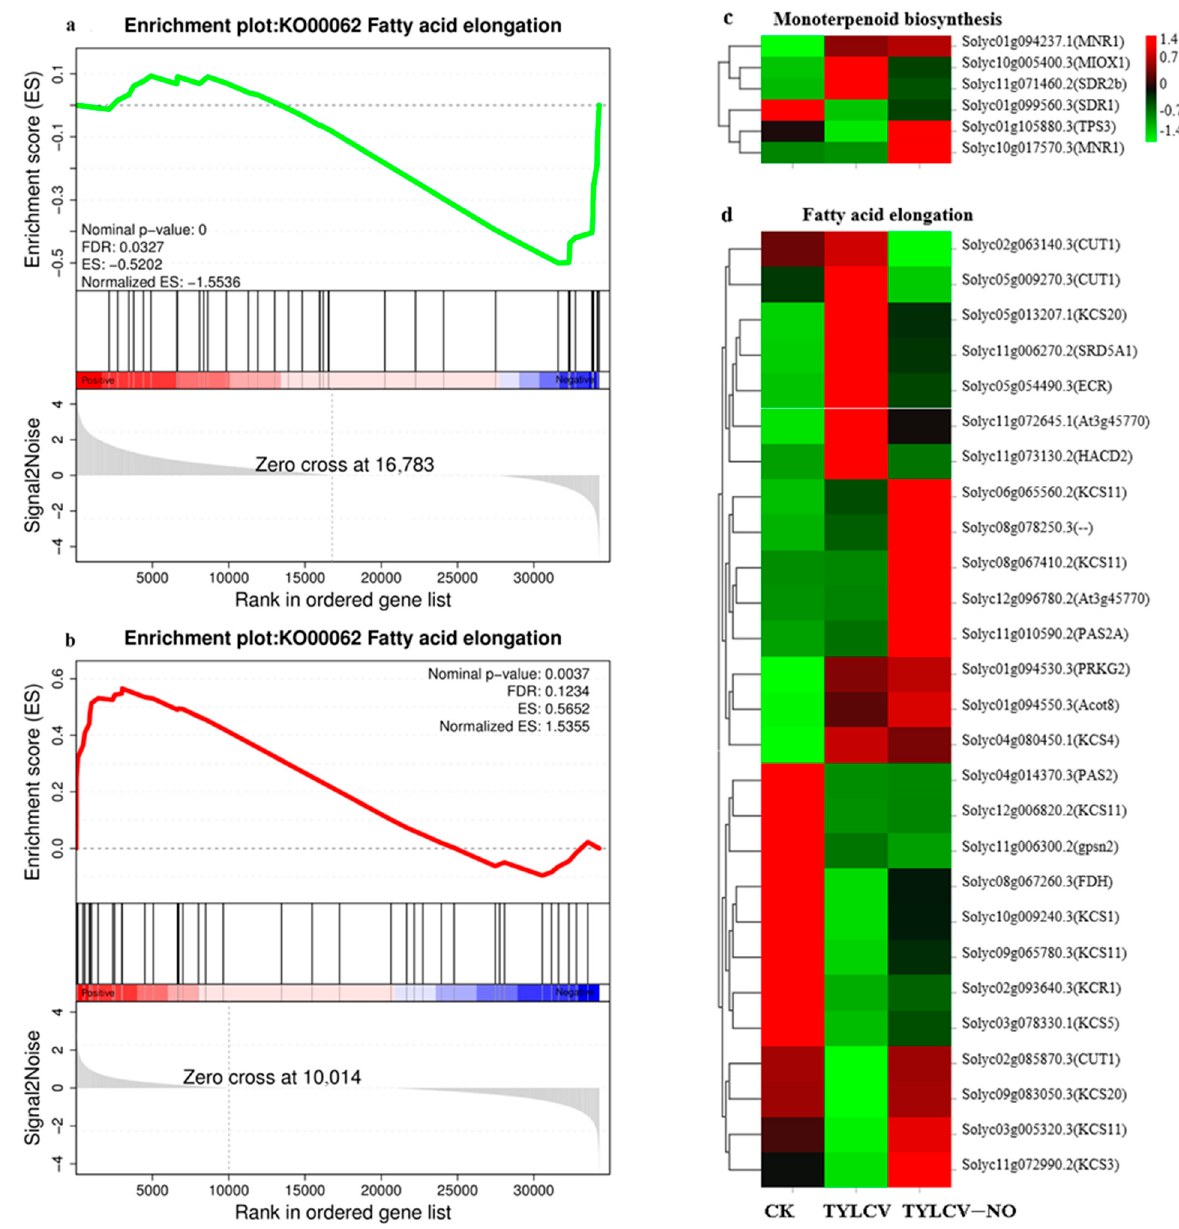
Figure 7. Expression of genes related to the biosynthesis of some key metabolites in tomato, ( a , b ) are the GSEA enrichment analysis of all genes generated by CK vs. TYLCV and TYLCV vs. TYLCV–NO, respectively. The expression data of all genes were used to rank the genes using Signal 2 Noise as the criterion. Top: 1 enrichment score (ES) value is calculated for each gene from left to right and is concatenated into a line, with the highest peak being the ES; middle: each black vertical line indicates a gene and its ranked position; bottom: matrix of gene and phenotype associations, with red being highly expressed in the first phenotype and blue being highly expressed in the second phenotype, ( c , d ) are the expression profiles of genes related to monoterpene biosynthesis and fatty acid elongation, respectively. Different colors indicate the expression level of each gene after normalization by FPKM.